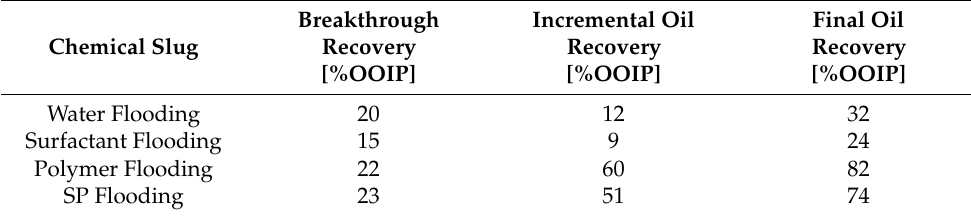
Table 3. Summary results of flood